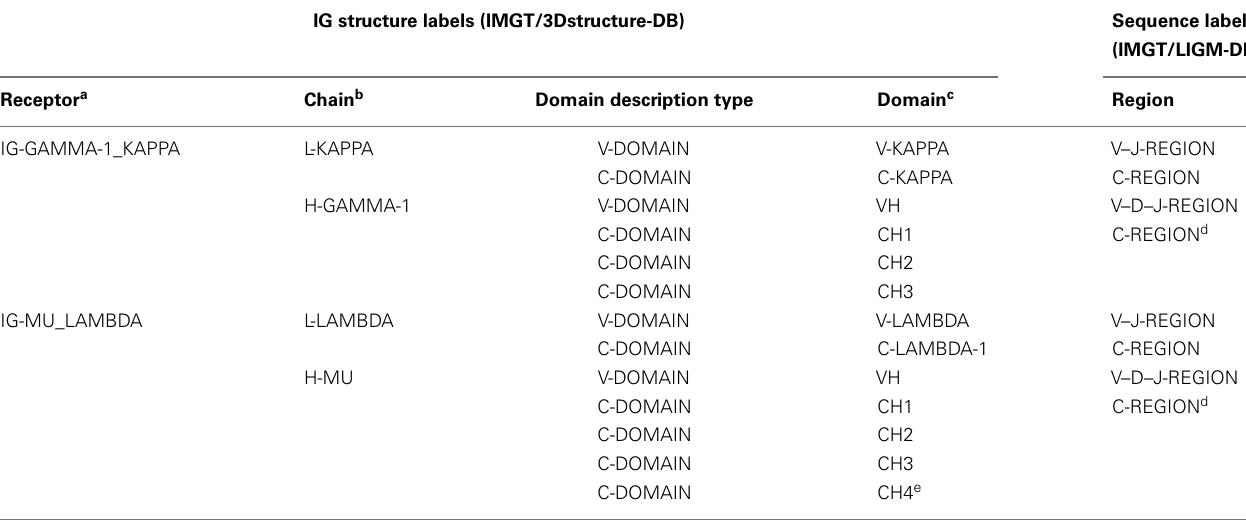
Table 1 | Immunoglobulin (IG) receptor, chain, and domain structure labels and correspondence with sequence labels . IG structure labels